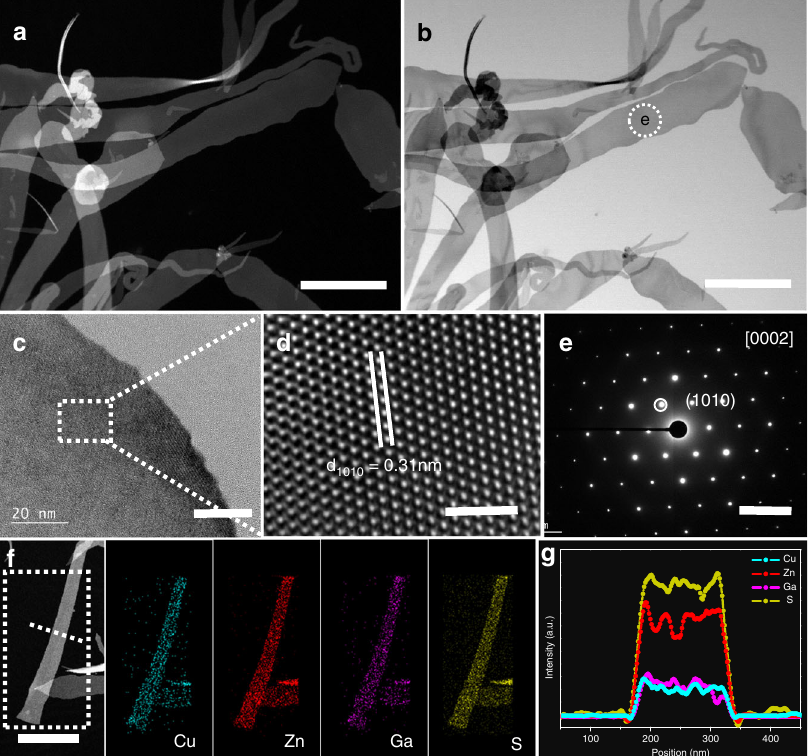
Fig. 3 Characterization of the synthesized wurtzite CZGS nanobelts. a , b HAADF-STEM and TEM micrographs. c HRTEM image. d Enlarged HRTEM image of the selected area in c . e SAED pattern of one part in b . f EDS mapping of one part of the randomly selected CZGS nanobelt. g Smoothing simulation EDS-line scan analysis of the selected area in f . Scale bars are 500 nm for a , b , 20 nm for c , 2 nm for d , 5 1/nm for e , 500 nm for f ,